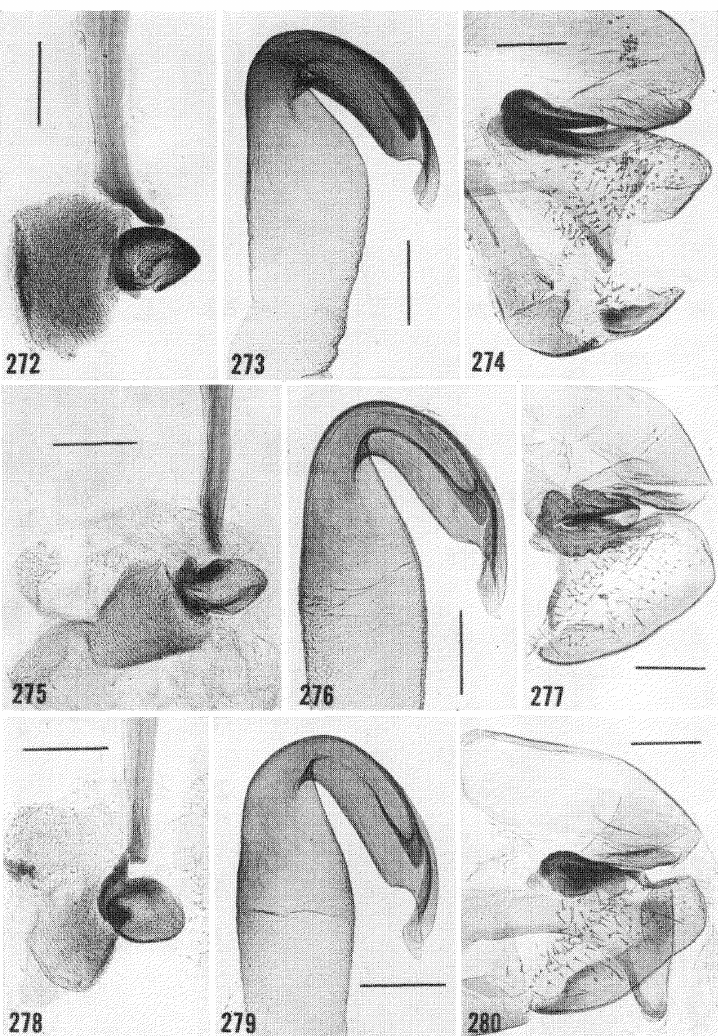
Figs. 272-280. Cockroach male genitalia. Epilampra az,teca. 272-274. (75 USNM). Territory Amazonas, Mt. Marahuaea, Venezuela (det. Al- buquerque). 275-277. (131 USNM). Napo Santa Cecilia, Rio Aguarieo, Ecuador (det. Roth). 278-280. (130 USNM). Same data as Figs. 275-277. (det. Roth). (scale 0.2